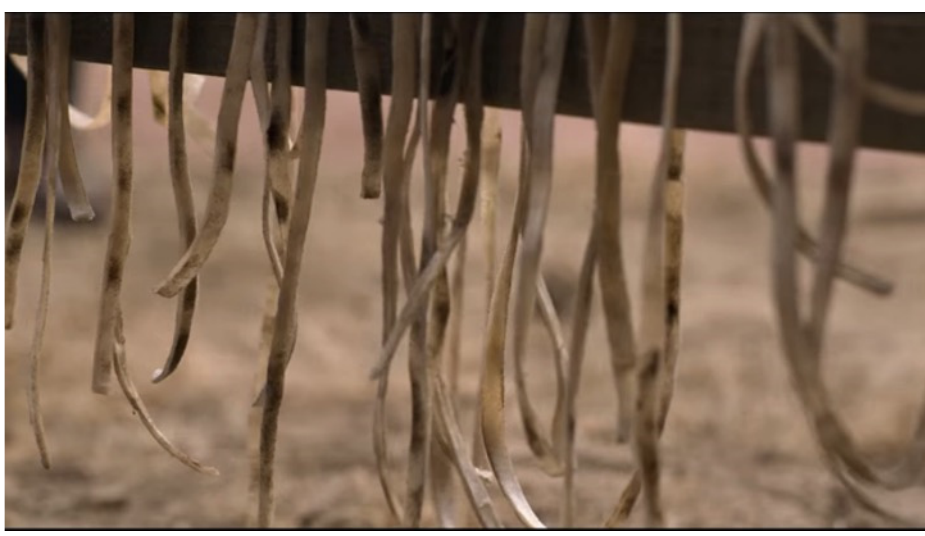
Figure 18. The Power of the Dog . Netflix.